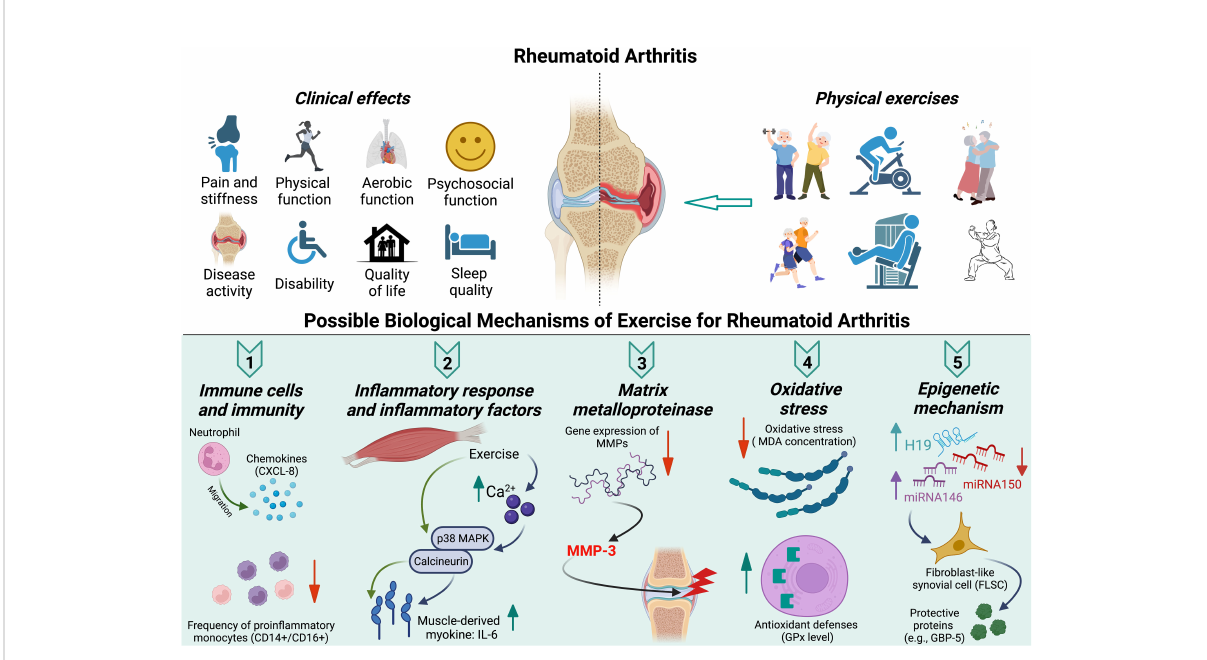
FIGURE 1 Clinical effects and possible biological mechanisms of exercise for rheumatoid